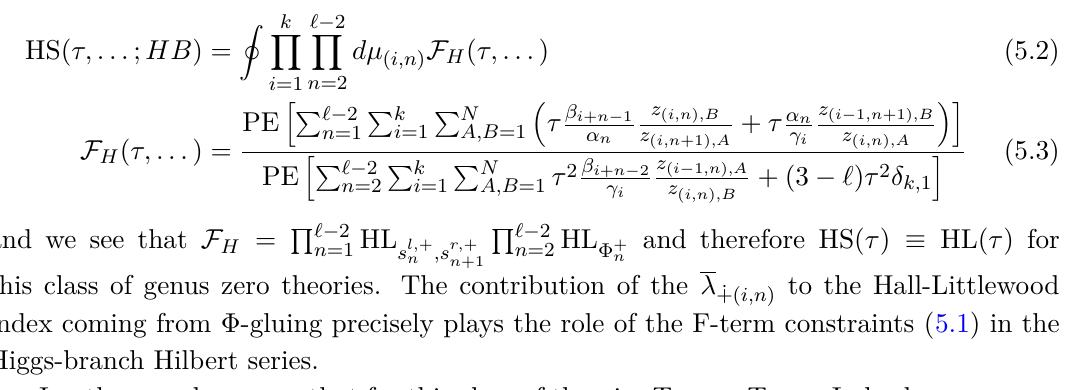
ˆ ˆ ˆ ˆ ∼ = ˆ C . Underlined are those states, C ⊕ C ( ⊕ C ( C ( ) ⊕ ) 0(0 , 0) (0 , 0) 1 1 , 0 ) 0 , 1 , 1 2 2 2 2 = E − 2 j r = 0 and thus can contribute to the right-handed 3 ˙ − 2 − 2